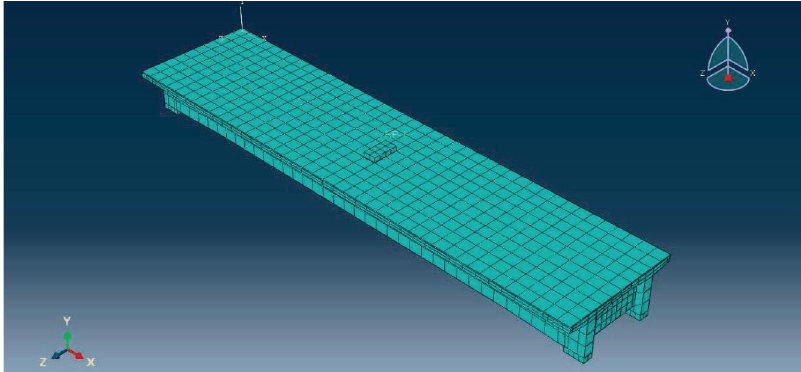
Figure 11: Carriageway slab model.